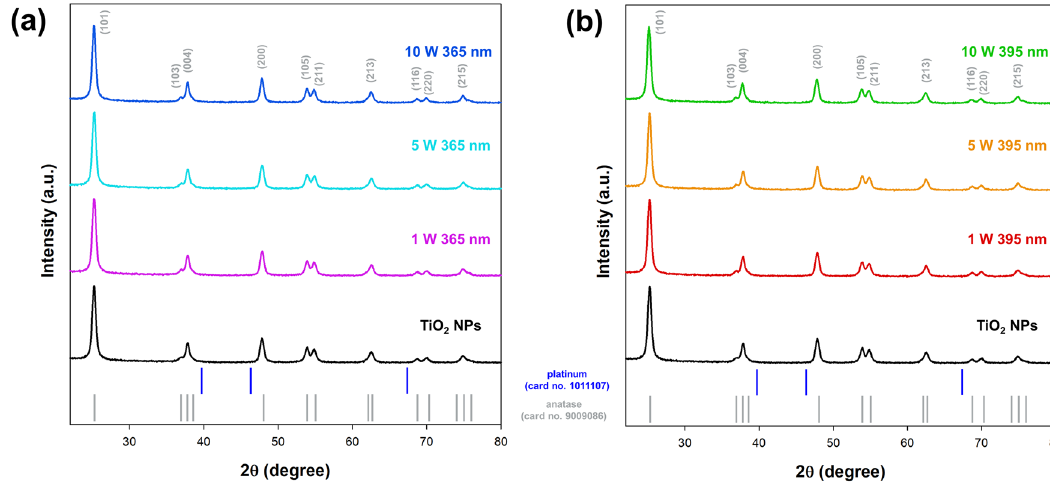
Figure 2. The XRD patterns for samples series: ( a ) 365 nm and ( b ) 395